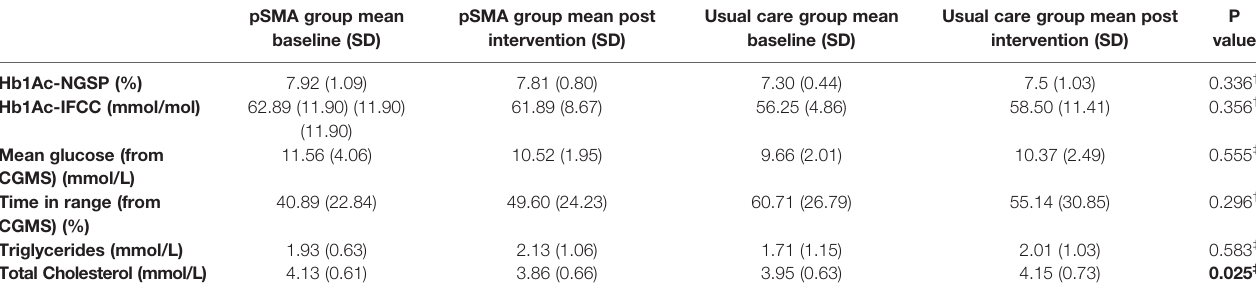
TABLE 6 | Glycemic control and lipids at baseline and 12 weeks. pSMA group mean baseline